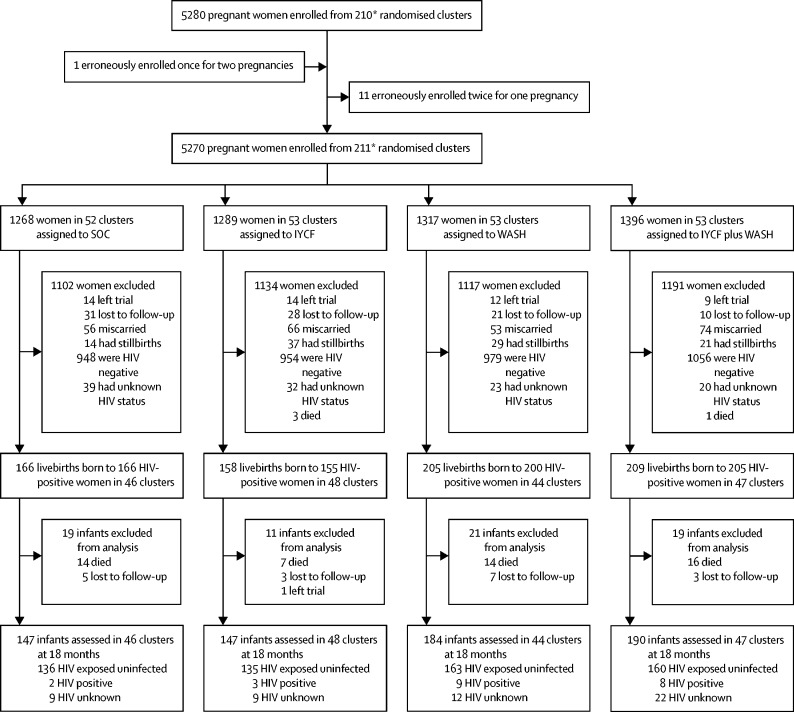
Trial profileSOC=standard of care. IYCF=infant and young child feeding. WASH=water, sanitation, and hygiene. *212 clusters were randomly assigned, 53 in each of the four trial groups. After randomisation, one cluster was excluded because it was in an urban area, one was excluded because the village health worker covering it mainly had clients outside the study area, and two more were merged on the basis of subsequent data for village health worker coverage. Three new cluster designations were created because of anomalies in the original mapping. For two of these cluster, the trial group was clear; the third contained areas that were in two trial groups, and was assigned to the under-represented group, resulting in 53 clusters in each group. All these changes occurred before enrolment began. When enrolment was completed, however, no women were enrolled in one cluster in the SOC group and thus 211 clusters were available for analysis.